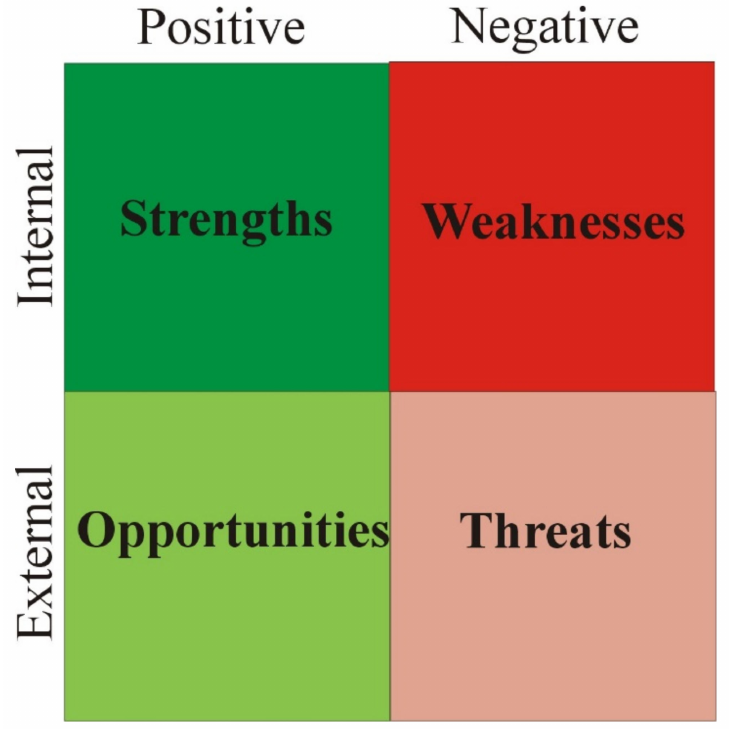
Figure 18. SWOT analysis diagram (own